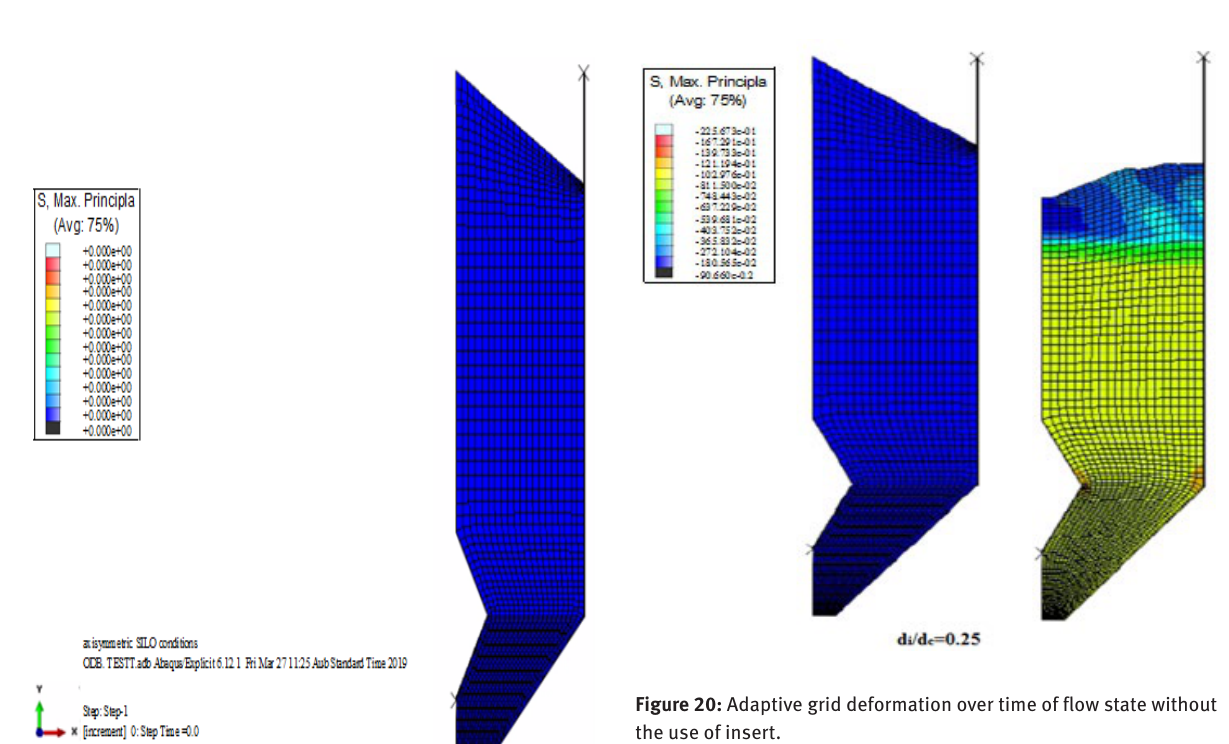
Figure 18: The comparison is between the pressure produced by the numerical study and the pressure produced by the experimental study Figure18 : The comparison is between the pressure produced by the numerical study without the use of an insert. and the pressure produced by the experimental study without the use of an insert.